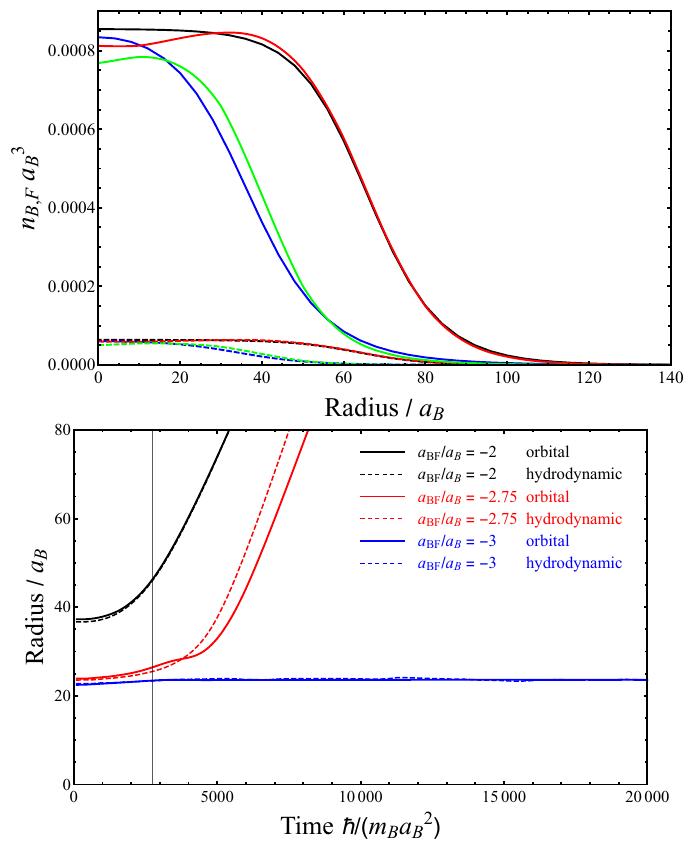
Figure 4: Upper frame: Radial densities of bosonic (solid lines) and fermionic (dashed lines) components for two Bose-Fermi droplets. Blue (hydrodynamical ap- proach) and green (atomic-orbital method) colors correspond to a droplet consisting of 35 fermions and 350 bosons whereas colors black and red describe the case for = − 3 a 120 fermions and 1250 bosons. In both cases a . Lower frame: Radius of a BF B mixture consisting of 35 fermions and 350 bosons for different values of the coupling constants a , according to the legend, as a function of time. The time is counted BF from the moment when the trap starts to be removed (at the time marked by the | / a > 2.8), i.e. leading to vertical line the trap is fully removed). Both stable ( | a BF B | / a ≤ 2.8) cases are shown. The dashed formation of a droplet and unstable ( | a BF B and solid lines are obtained within the hydrodynamic and atomic-orbital approaches,